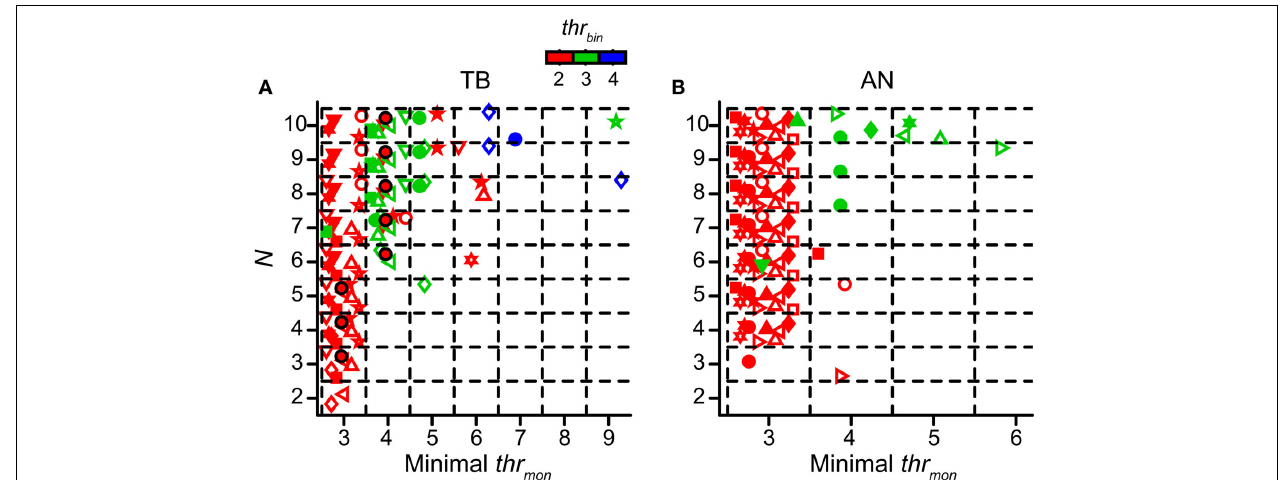
FIGURE 9 | Minimal values of thr mon of accepted simulation cases. Simulations with TB (A) ( n = 12) and AN (B) ( n = 13) datasets. Different colors represent different values of thr bin . Each symbol represents